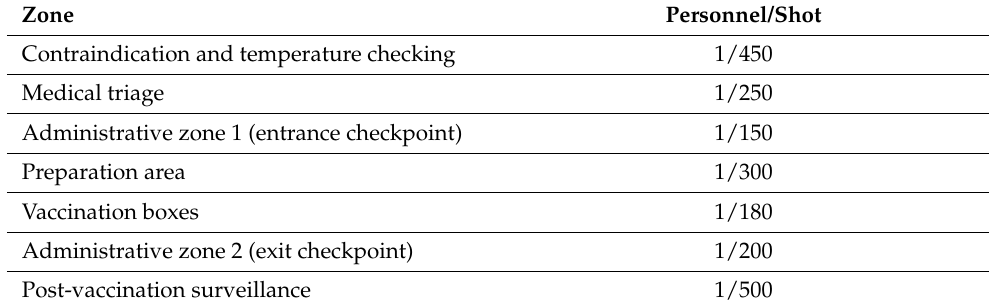
Table 1. Number of personnel required per shot administered in a day (10 h), in each zone.